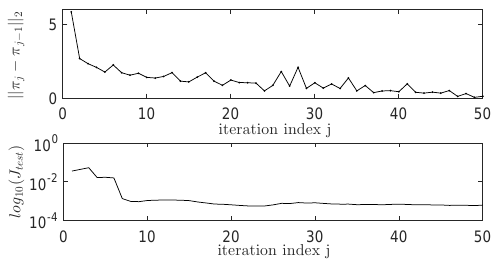
Figure 9. The nonlinearly parameterized IMF-AVI (NP-IMF-AVI)